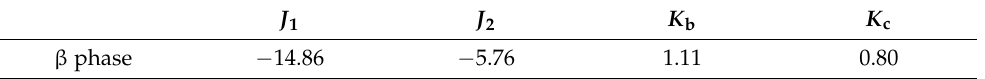
Table 2. In-plane exchange parameters (meV/Cr) estimated from our DFT